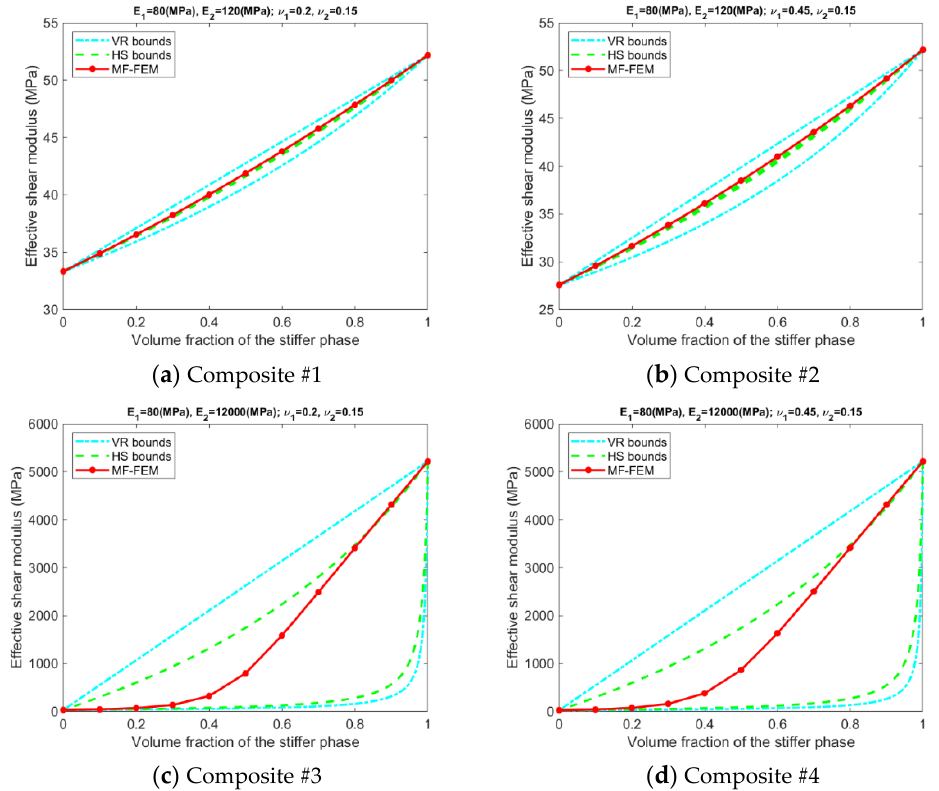
Figure 3. MF-FEM predictions and VR/HS bounds of effective Young’s modulus.